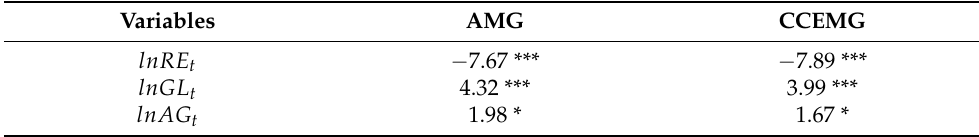
Table 9. Robustness check test (CO 2